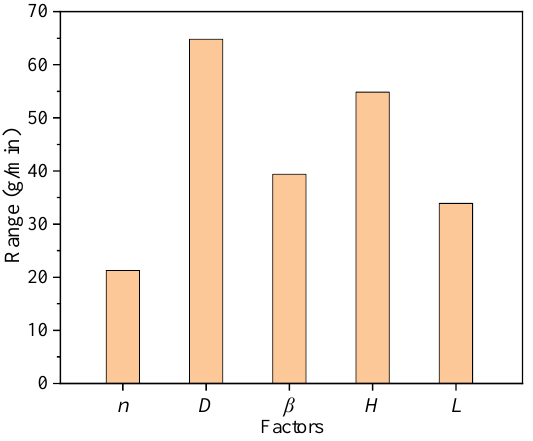
Figure 18. Range analysis of orthogonal test.